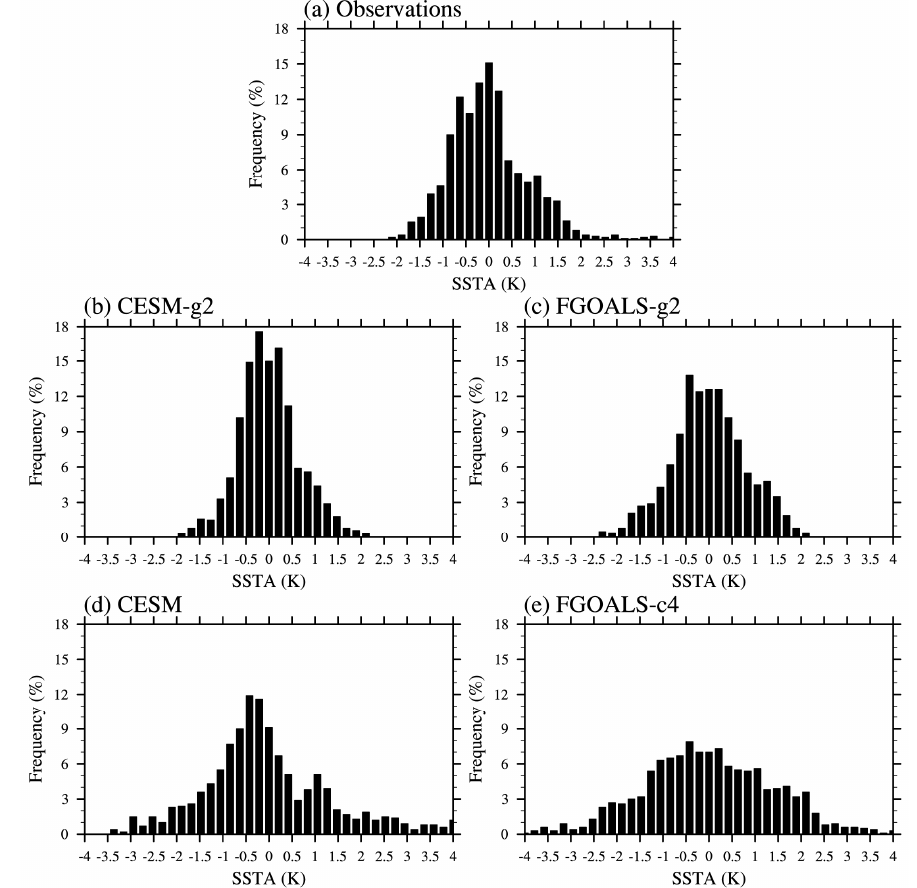
Figure 1. Distribution histograms of the monthly sea surface temperature (SST) anomalies averaged over Niño-3 (5° N–5° S, 150°–90° W) region from ( a ) the observations for years 1900–1999 and from the four models: ( b ) CESM-g2, ( c ) FGOALS-g2, ( d ) CESM, ( e ) FGOALS-c4 for years 401–500 in the pre-industrial (PI)-control runs. The width of the bin was 0.2 K.